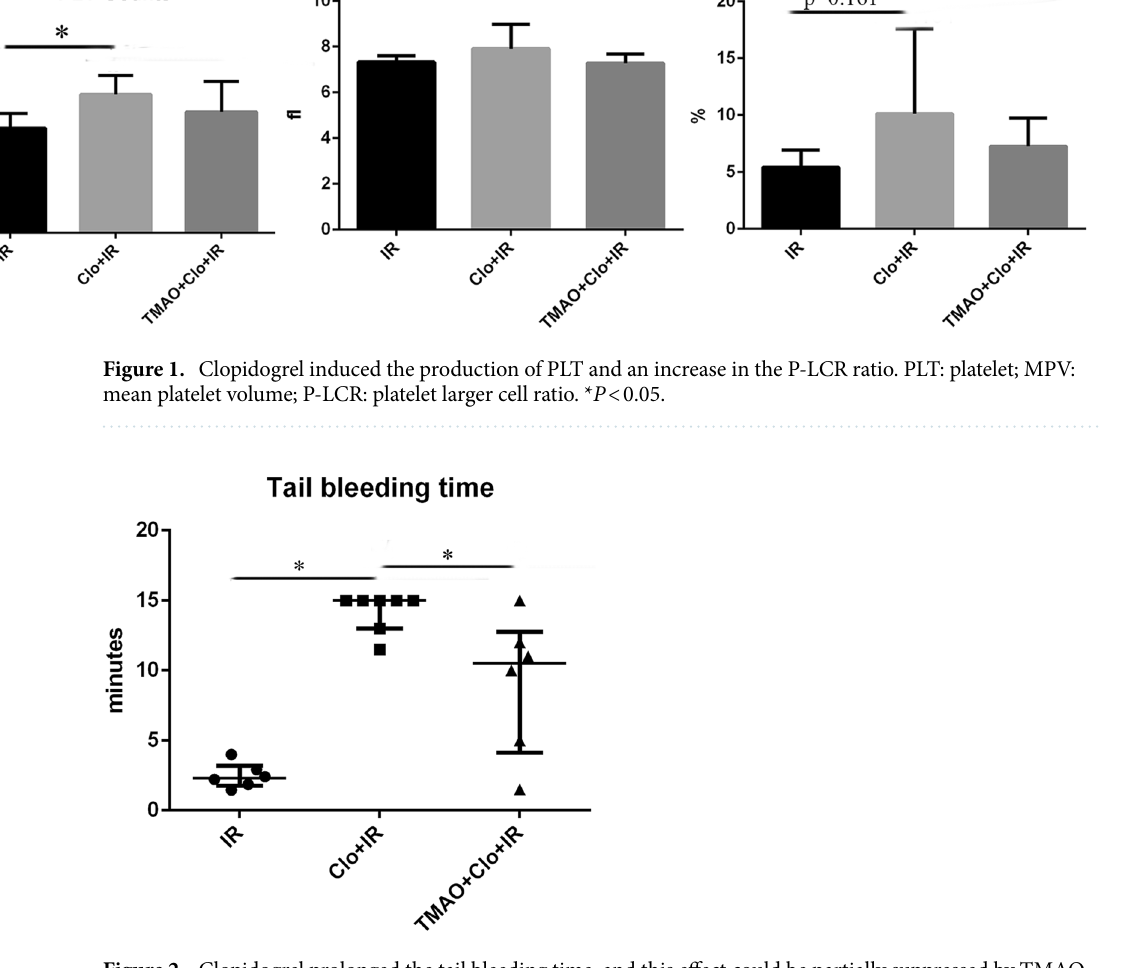
Figure 2. Clopidogrel prolonged the tail bleeding time, and this effect could be partially suppressed by TMAO. * P <